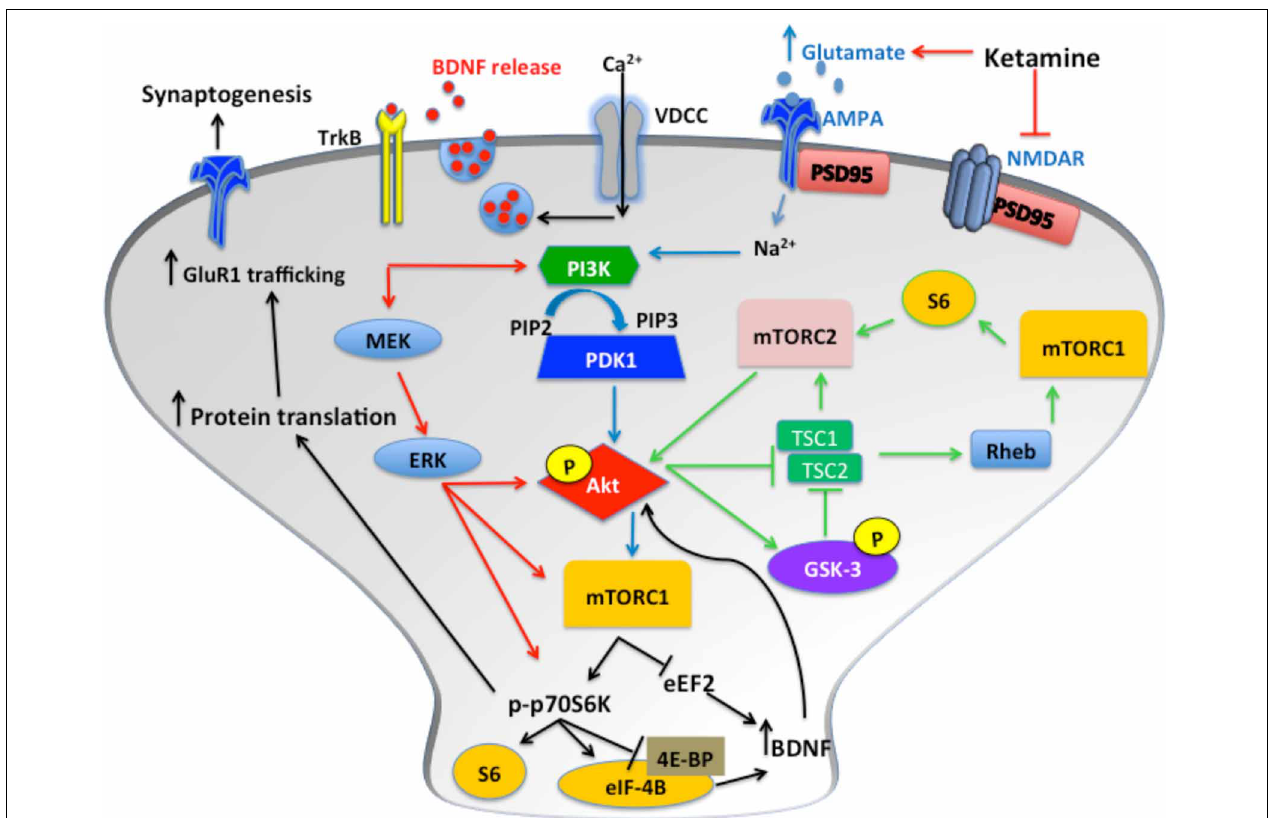
FIGURE 1 | Following blockade of NMDARs, phosphorylation of Akt activates mTOR complex 1 (mTORC1), which results in increased p70S6K phosphorylation and increased protein translation via inhibition of 4E-BP and release of eIF-4B. Glutamate binds AMPARs, which induces depolarization of the membrane, enabling Ca 2 + influx through VDCCs. This results in BDNF release from synaptic vesicles. The subsequent binding of